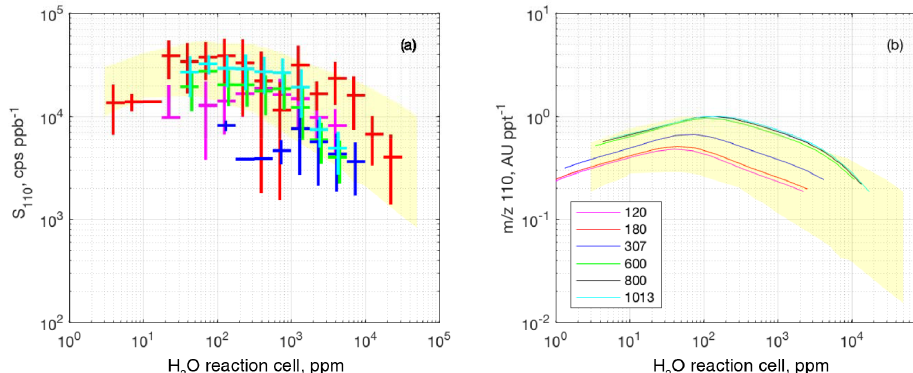
Figure 7. Same as Fig. 5 except for O −